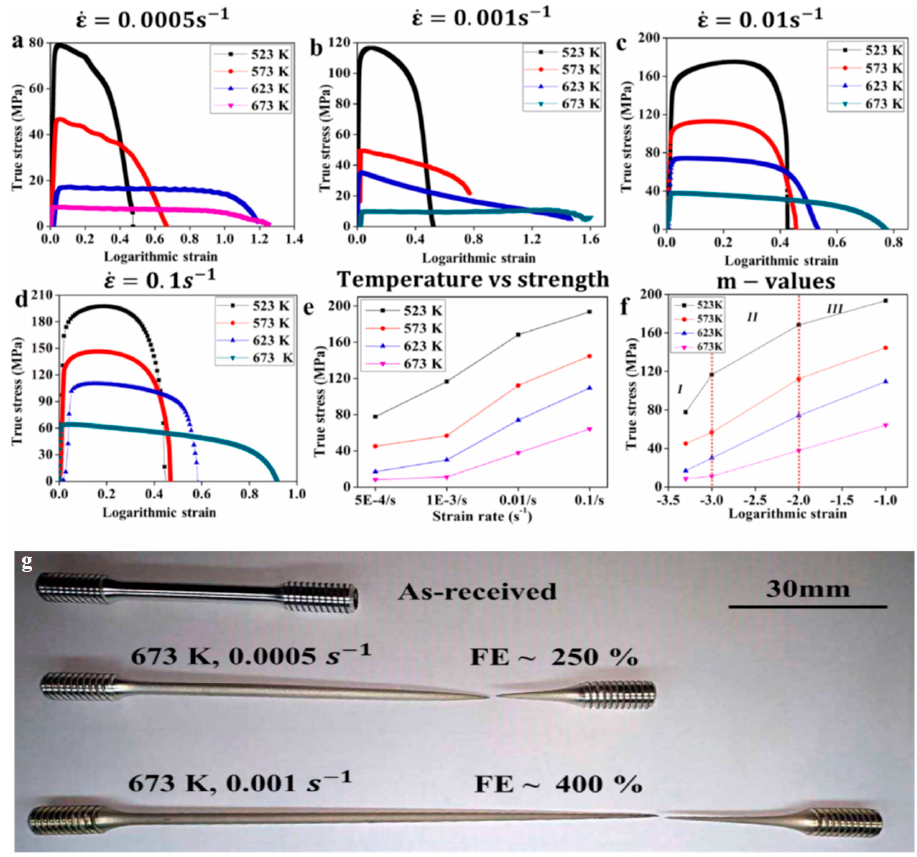
Figure 5. Superplastic deformation behavior of the Mg alloy: ( a – f ) are the real stress–strain curves at different temperatures and different deformation rates; ( g ) is the superplastic behavior of the actual tensile specimen [78]. Table 2. A review of recent research on the superplastic deformation instability of alloy materials.